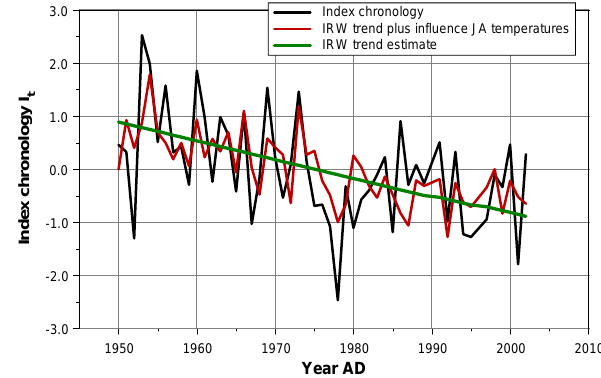
Fig. 2. SRF estimates for the Thelon TRW chronology. Period: 1950–2002. The black line represents the normalized indices, the green line the estimated IRW trend and the red line the trend plus influence of July–August temperatures. The IRW trend appears to be a straight line with statistical significant differences for any trend difference [ µ t − µ s ]. The response ˆ α appears to be constant: 0.47 ±